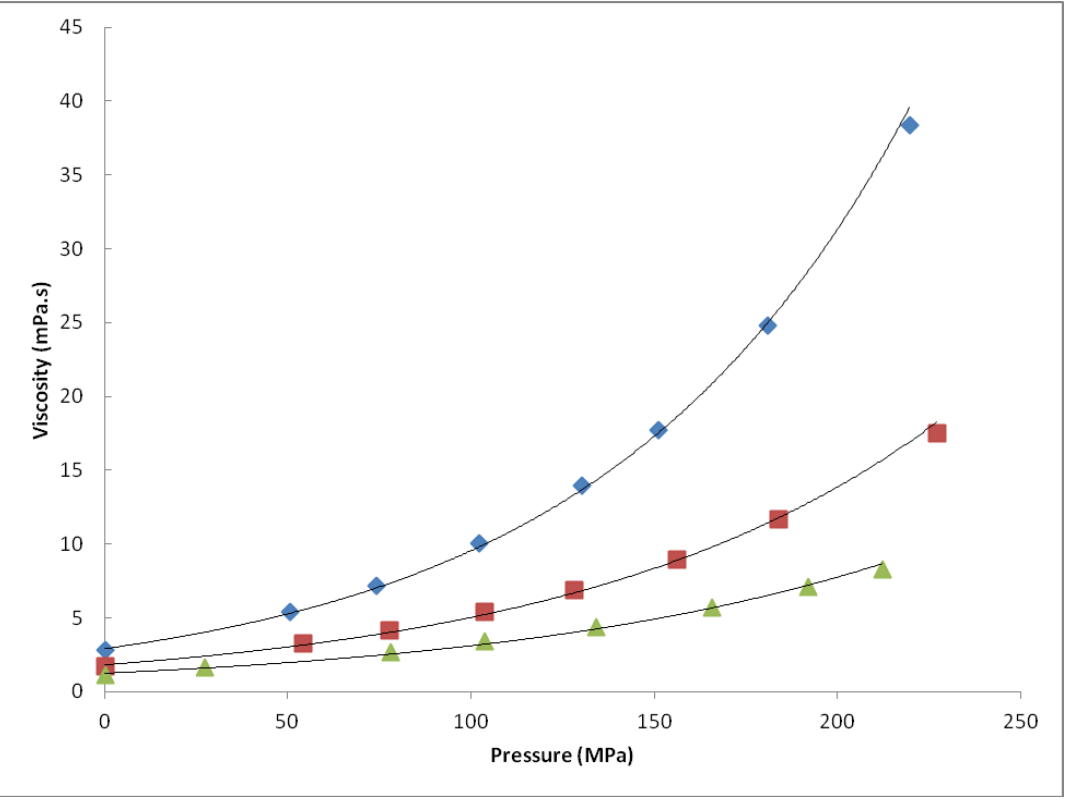
Figure 8. Variation of viscosity for Fuel 4 with temperature. ♦ 298 K, ■ 323 K, and ▲ 348 K.